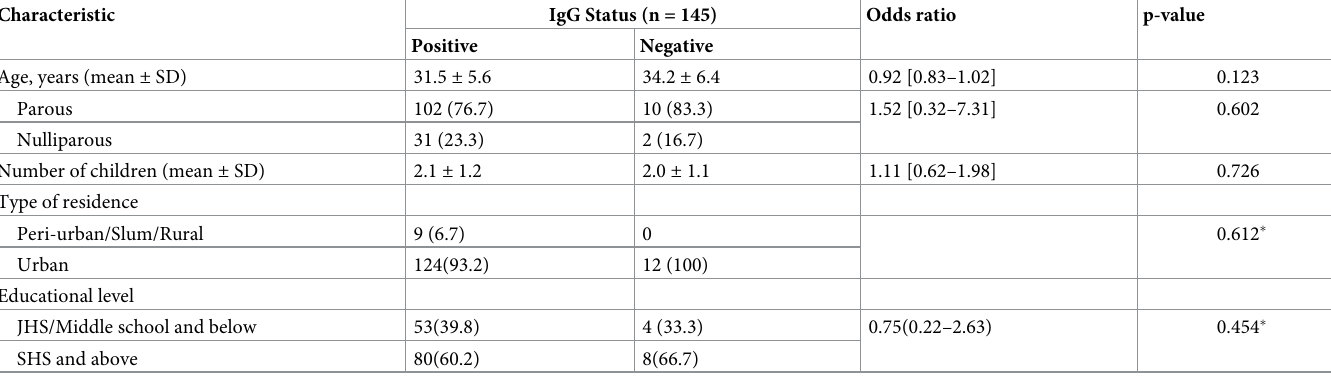
Table 4. Factors associated with IgG positivity in study